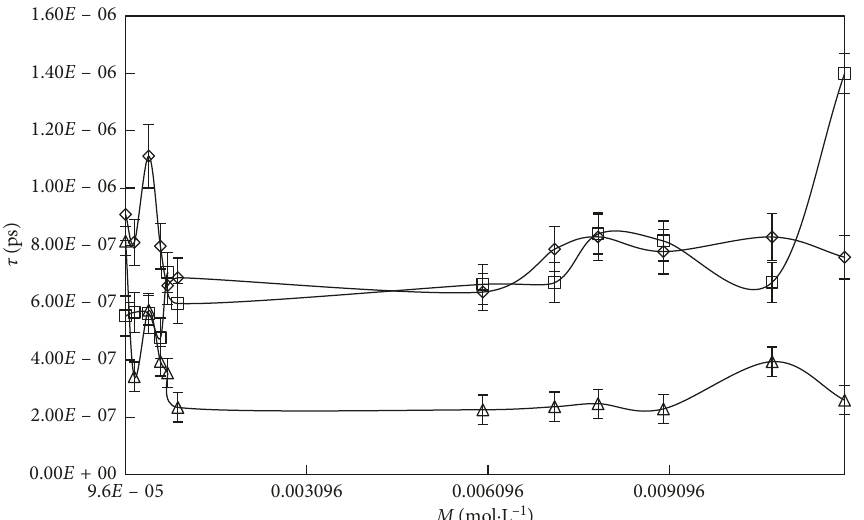
Figure 2: The τ value of the SDS-rich surfactant at the three different temperatures � 293.15 ( ◊ ), 298.15 ( □ ), and 303.15K ( △ ), respectively.